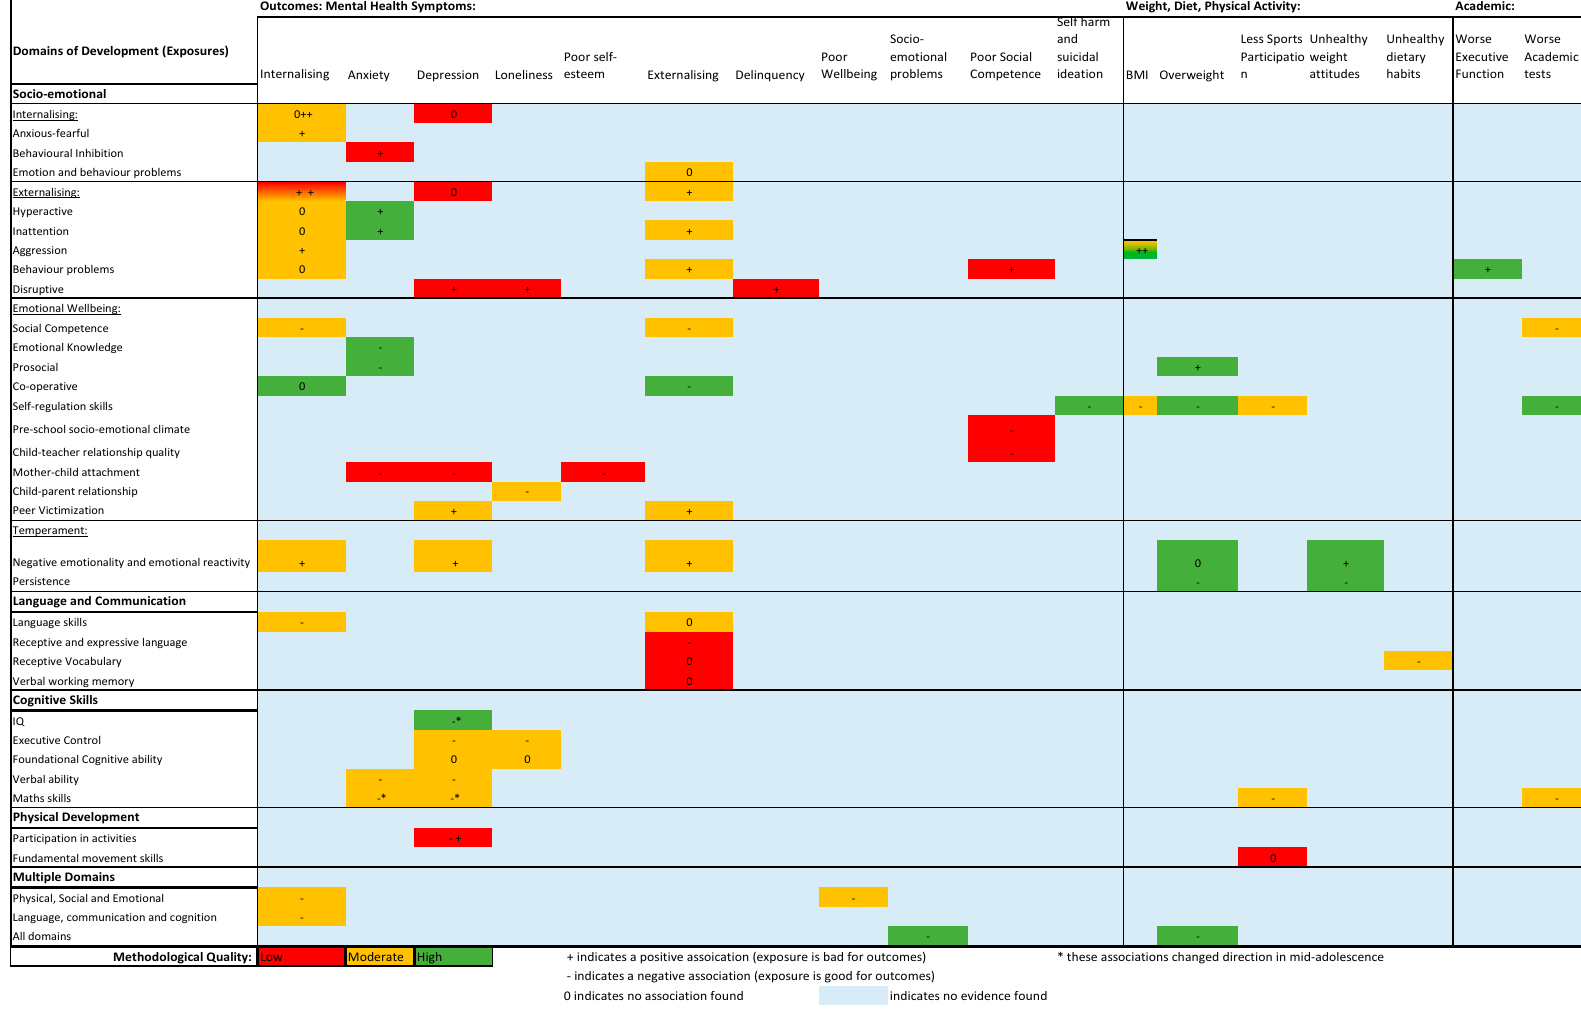
Figure 2. Evidence of associations between domains of “child development” (exposures) and outcomes of mental health symptoms, weight and academic.